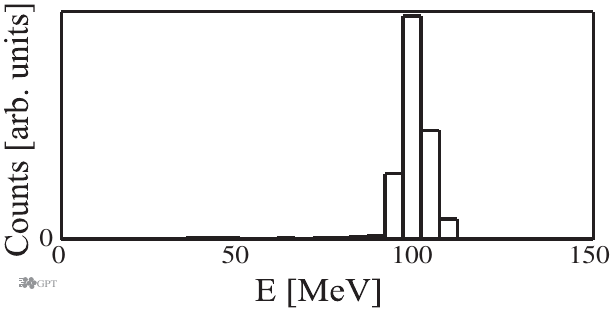
FIG. 2. Energy spectrum of the accelerated bunch at design settings (Table II) for a 0 ¼ 0 : 32 with injection 300 fs behind the laser pulse.